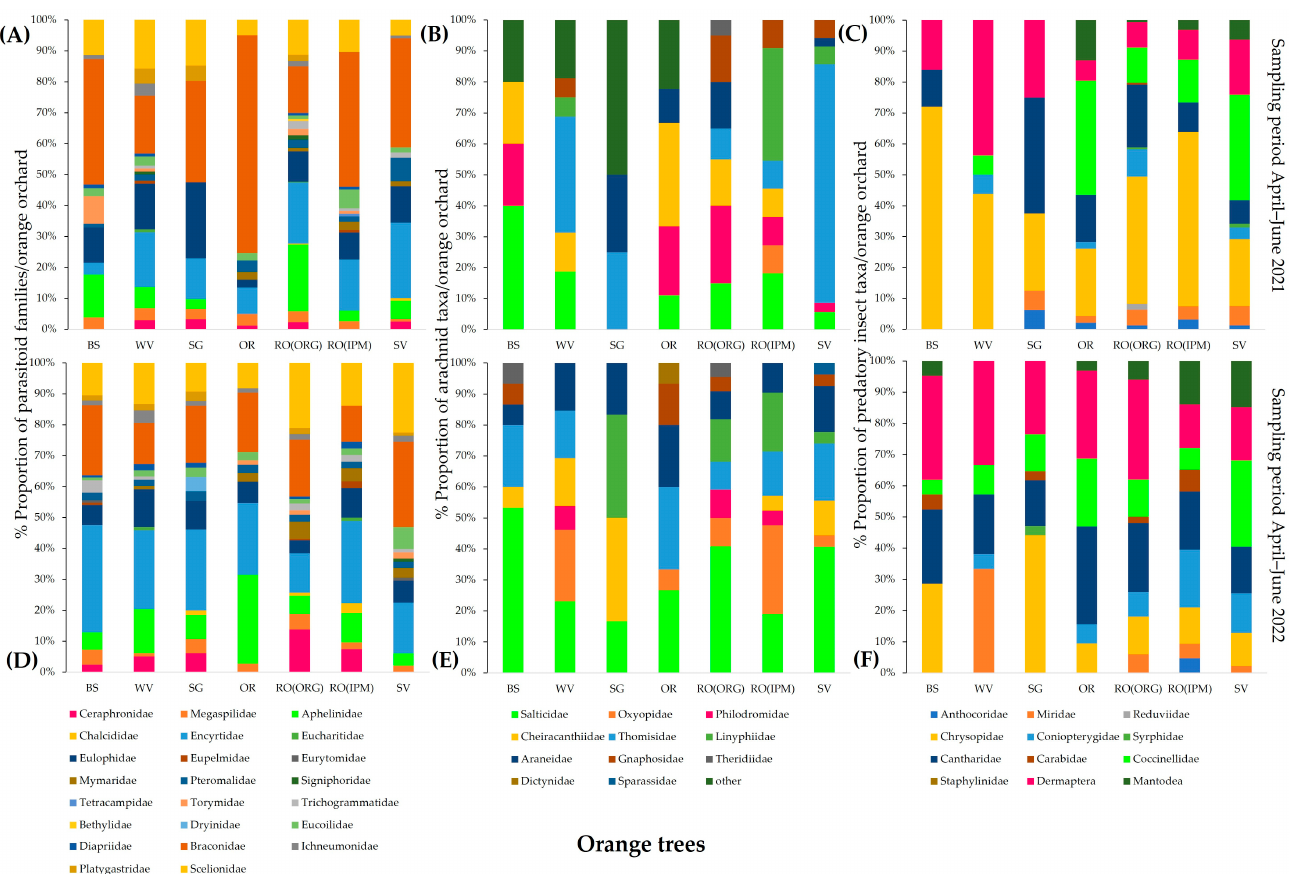
Figure 10. Community composition of natural enemies on orange trees in orchards with different field margin management. Sampling period from April to June 2021: ( A ) Hymenoptera parasitoids; ( B ) arachnid predators; ( C ) insect predators. Sampling period from April to June 2022: ( D ) Hymenoptera parasitoids; ( E ) arachnid predators; ( F ) insect predators. WV—weed vegetation; RO(ORG)—rosemary hedgerow (organic orchard); RO(IPM)—rosemary hedgerow (IPM orchard); OR—oregano hedgerow; SG—sage hedgerow; SV—savory hedgerow. Table 1. One-way ANOSIM between communities of natural enemies on field margins and orange trees in orchards with different field margin management. WV—weed vegetation; RO(ORG)— rosemary hedgerow (organic orchard); RO(IPM)—rosemary hedgerow (IPM orchard); OR—oregano hedgerow; SG—sage hedgerow; SV—savory hedgerow.